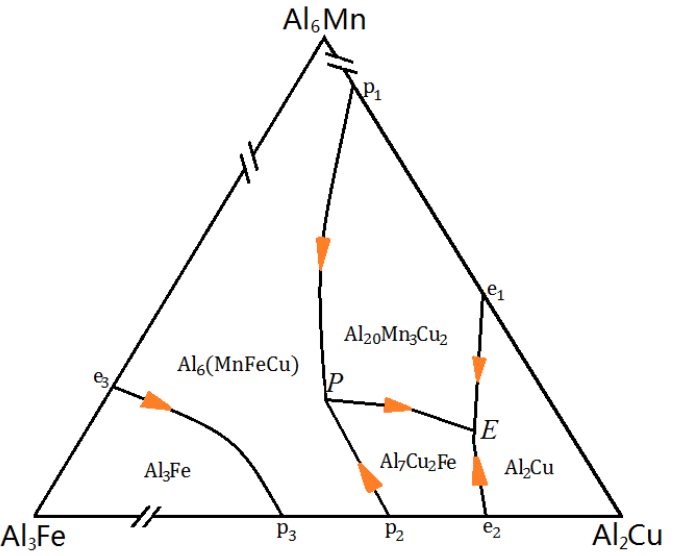
Figure 10. Phase diagram of intermetallics Al–Cu–Fe–Mn system alloy, reproduced from [25], with permission of Elsevier, 2005. Table 3. The possible solidification reactions in 2219 Al–Cu